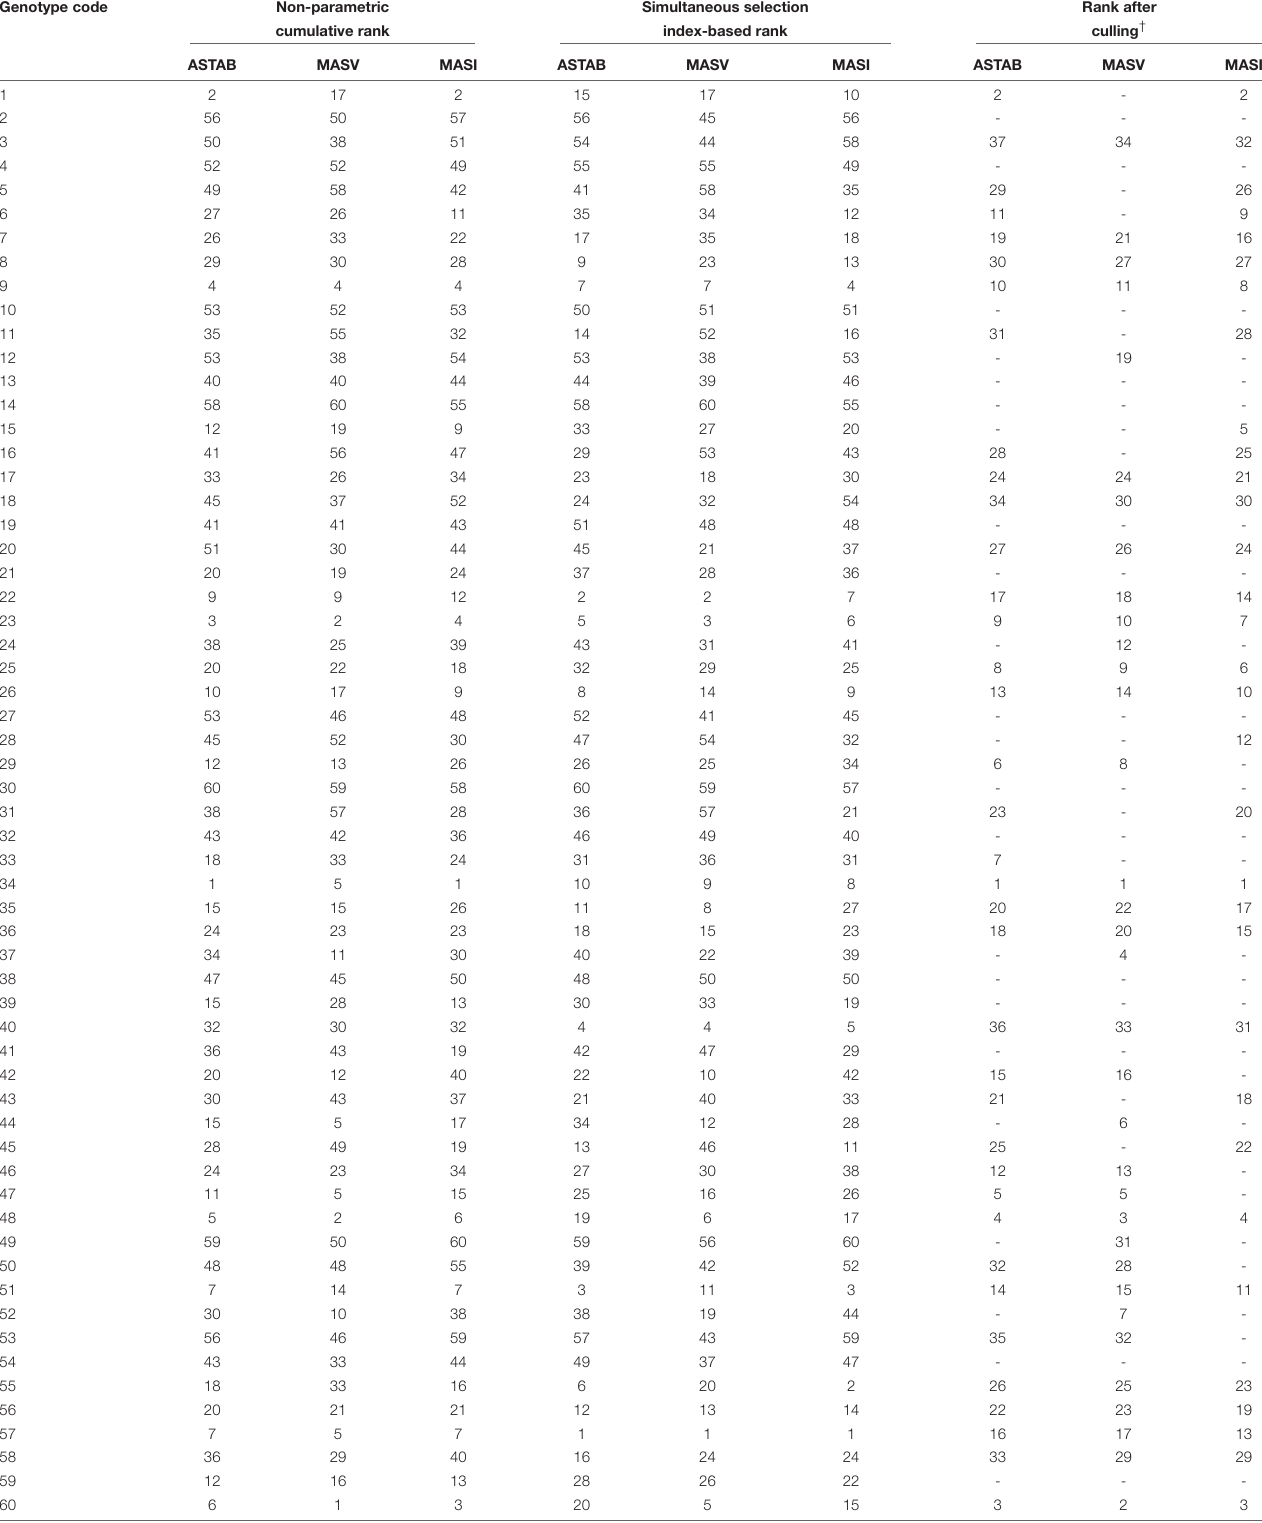
TABLE 4 | Ranking of finger millet genotypes through non-parametric, parametric, and culling methods. Genotype